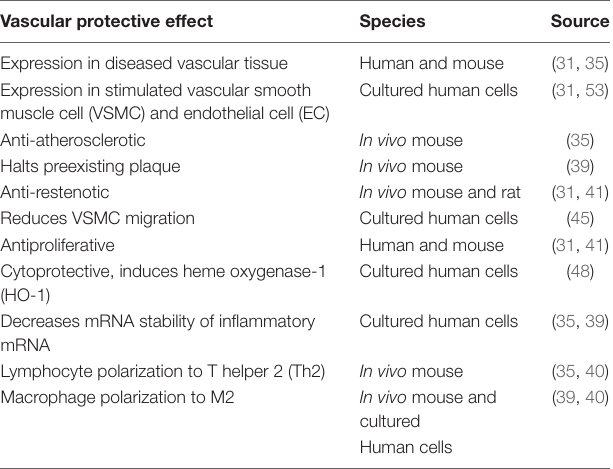
TAbLe 1 | Summary of vascular protective effects of interleukin-19 (IL-19).